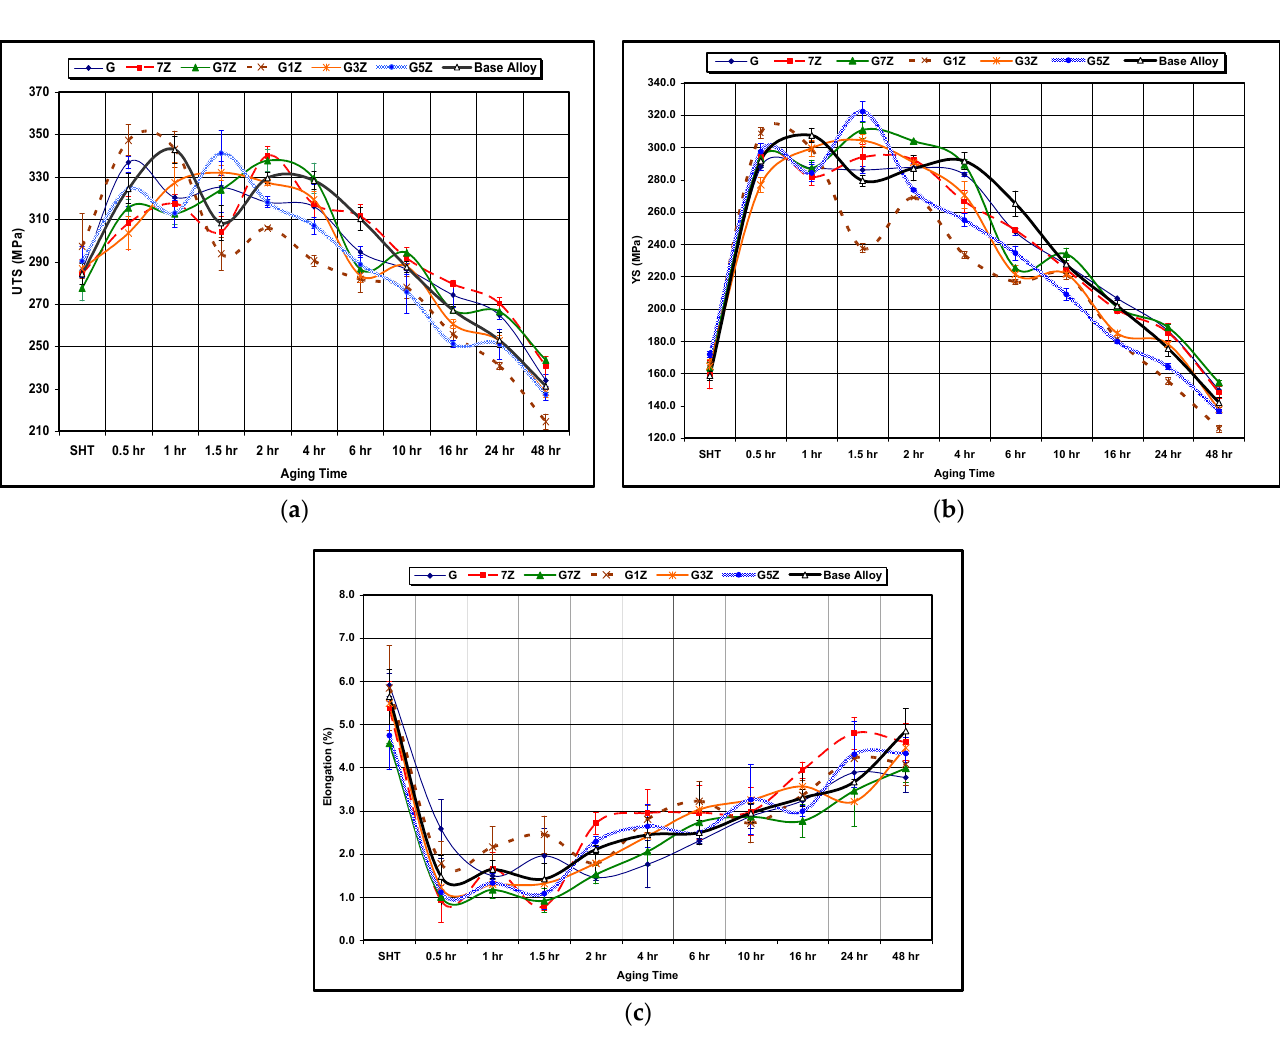
Figure 10. Effect of aging time on the tensile properties of the Zr-Ti alloy group at 180 °C aging temperature: ( a ) UTS, ( b ) YS, ( c ) %El.